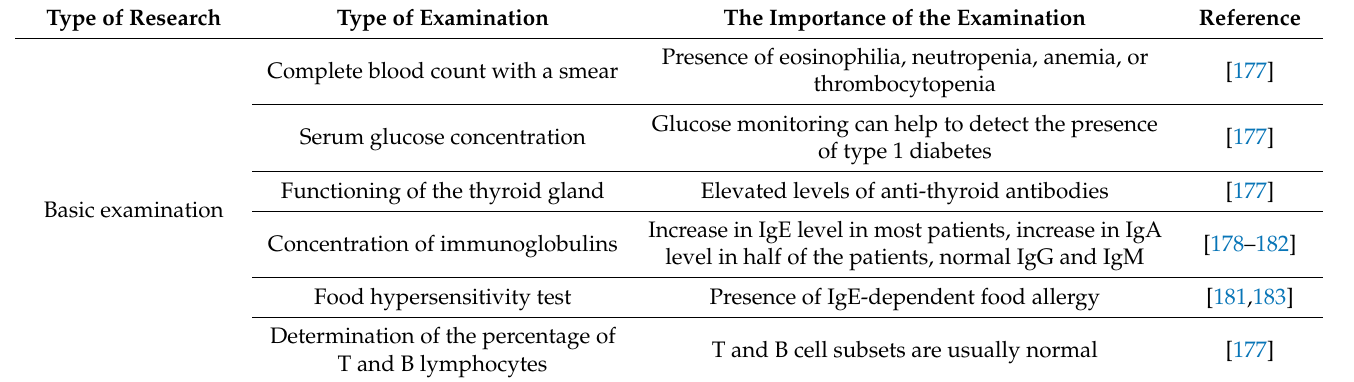
Table 5. Meanings of basic and specialized tests in the diagnosis of